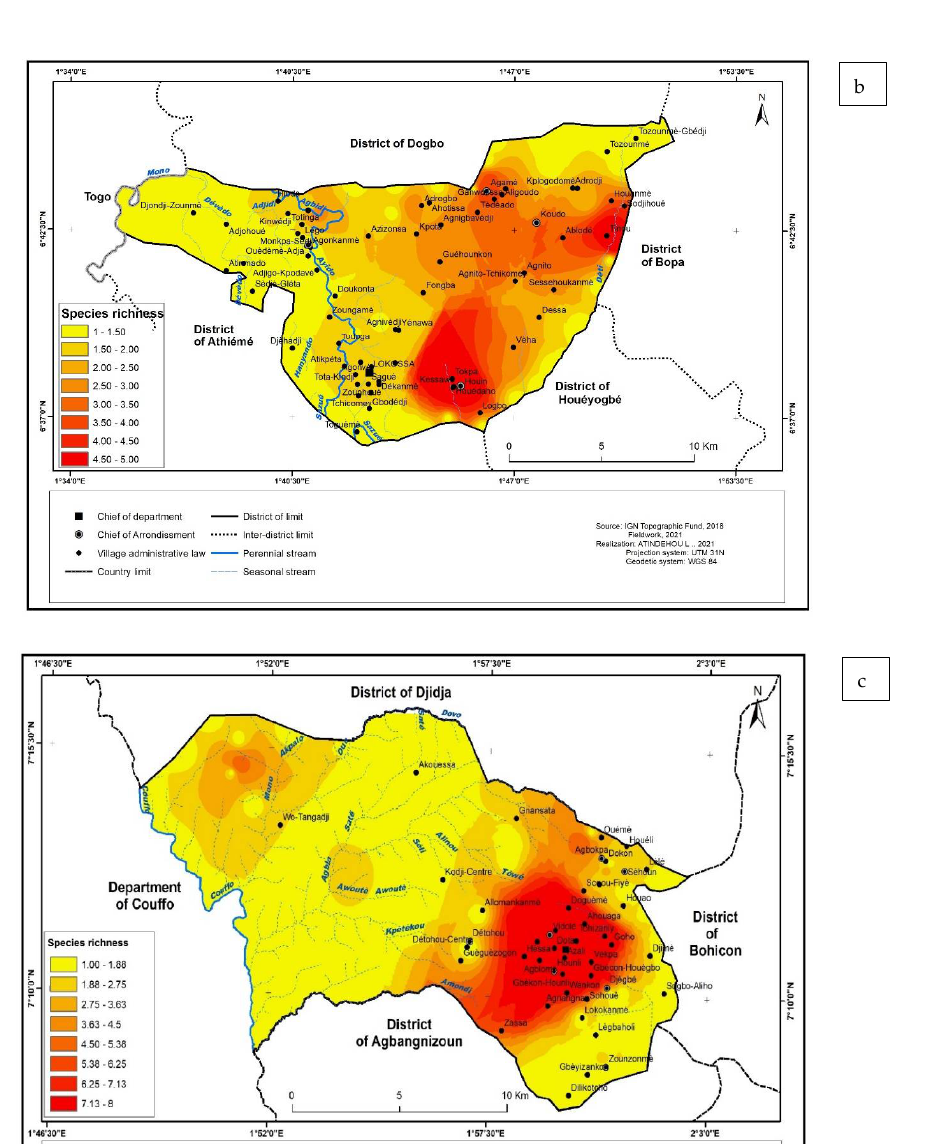
Figure 6. Species richness at the locality level within ( a ) Ketou; ( b ) Lokossa; and ( c ) Abomey cultural landscapes.